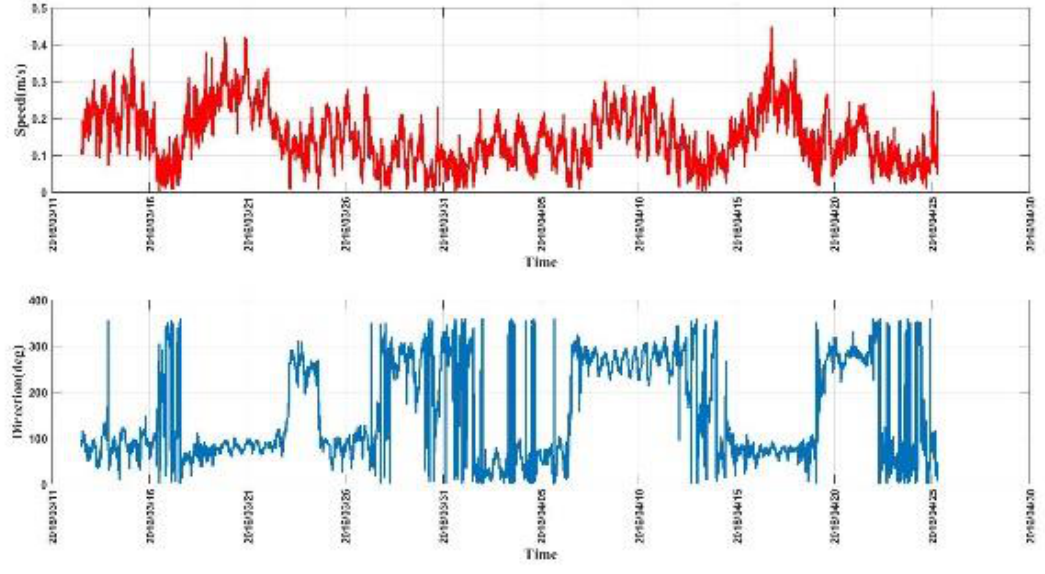
Figure 5. Current observation at Tang station at a depth of 14 meters.